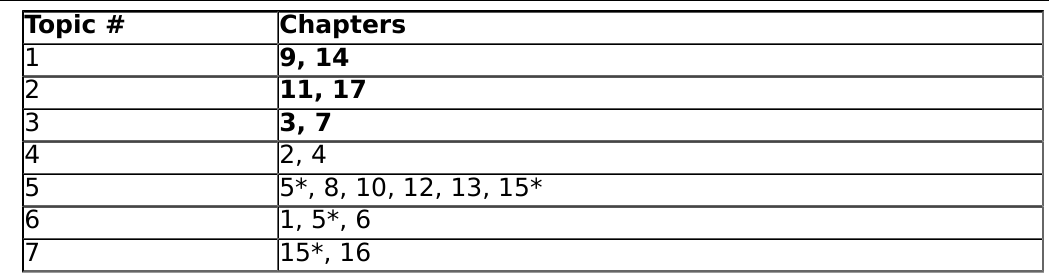
Table 4: Chapters assignment to topics, as produced by a 7-topic model. V. storyline chapters are denoted in bold. Asterisks denote chapters that were assigned to more than one topic with comparable